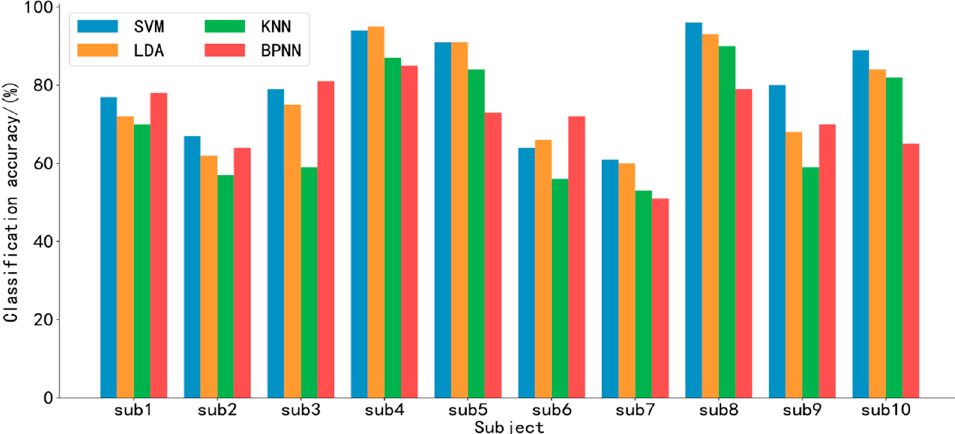
Figure 9. Classification accuracy comparison of different classifiers.